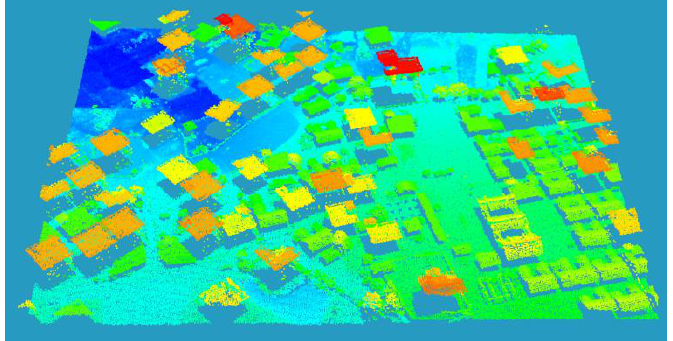
real non-ground point.